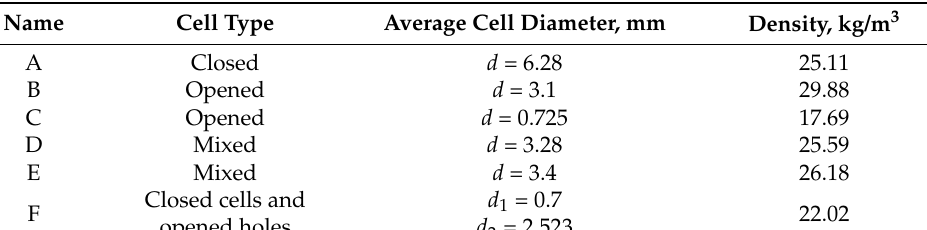
Table 1. Parameters of the investigated samples of polyurethane foams.